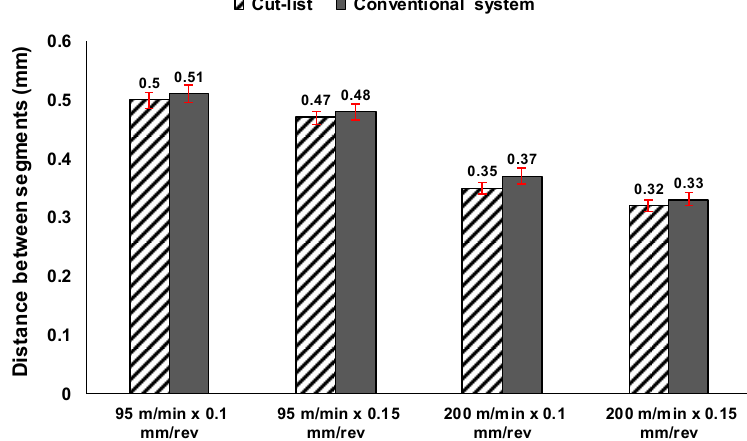
Figure 17. Average distance between serrated segments for the two systems at various cutting conditions.